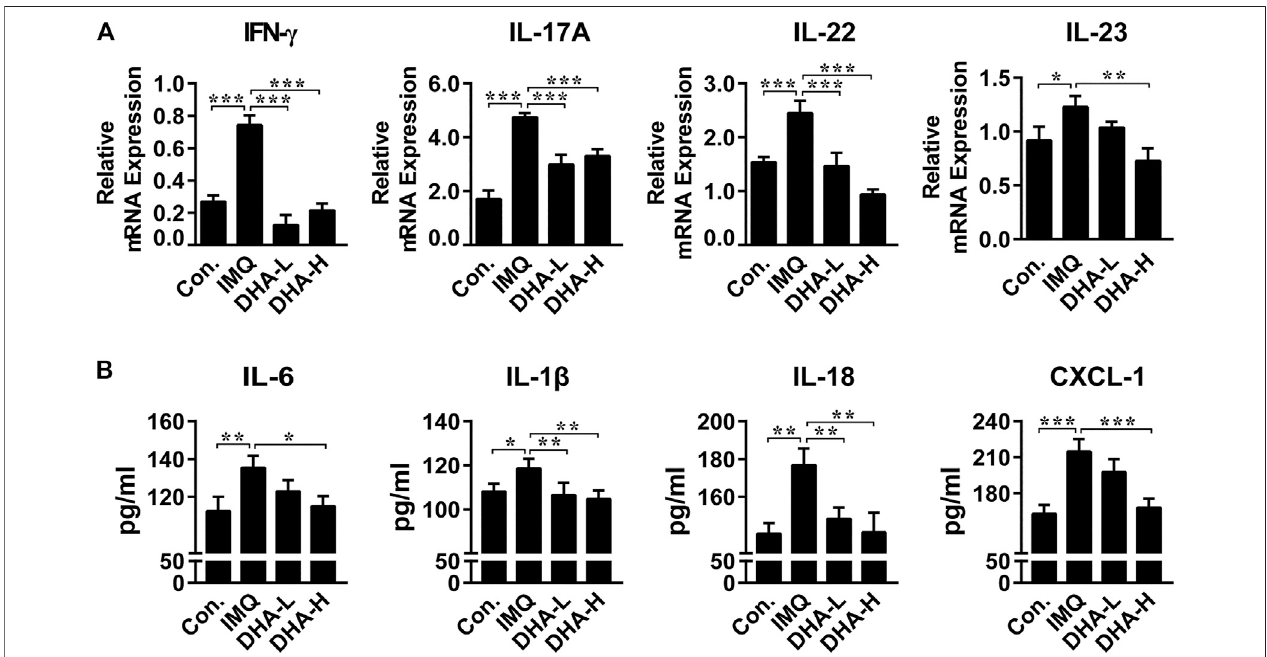
FIGURE 4 | DHA affected cytokines expression in psoriasis mice skin lesions. (A) IFN- γ , IL-17A, IL-22 and IL-23 mRNA levels in skin sections (30 mg) were analyzed by RT-PCR (IFN- γ , *** p < 0.001; IL-17A, *** p < 0.001; IL-22, *** p < 0.001; IL-23, * p (cid:2) 0.017, ** p (cid:2) 0.0010). (B) IL-6, IL-18, IL-1 β and CXCL-1 secretion in the supernatant from skins (50 mg) were measured by ELISA (IL-6, * p (cid:2) 0.011, ** p (cid:2) 0.0056; IL-18, ** p < 0.01; IL-1 β , * p (cid:2) 0.0295, ** p < 0.01; CXCL-1, *** p < 0.001). Statistical analysis was carried out using One-way ANOVA analysis of variance followed by Dunnett ’ s test ( n (cid:2) 4 – 6).